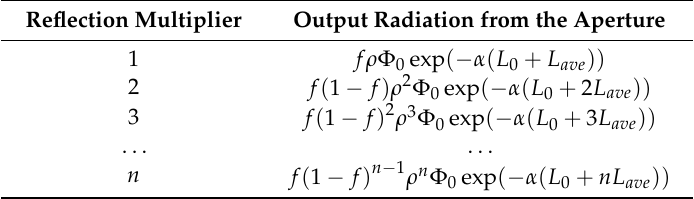
Table 1. Output light radiation after each reflection from an arbitrary diffuse integrating